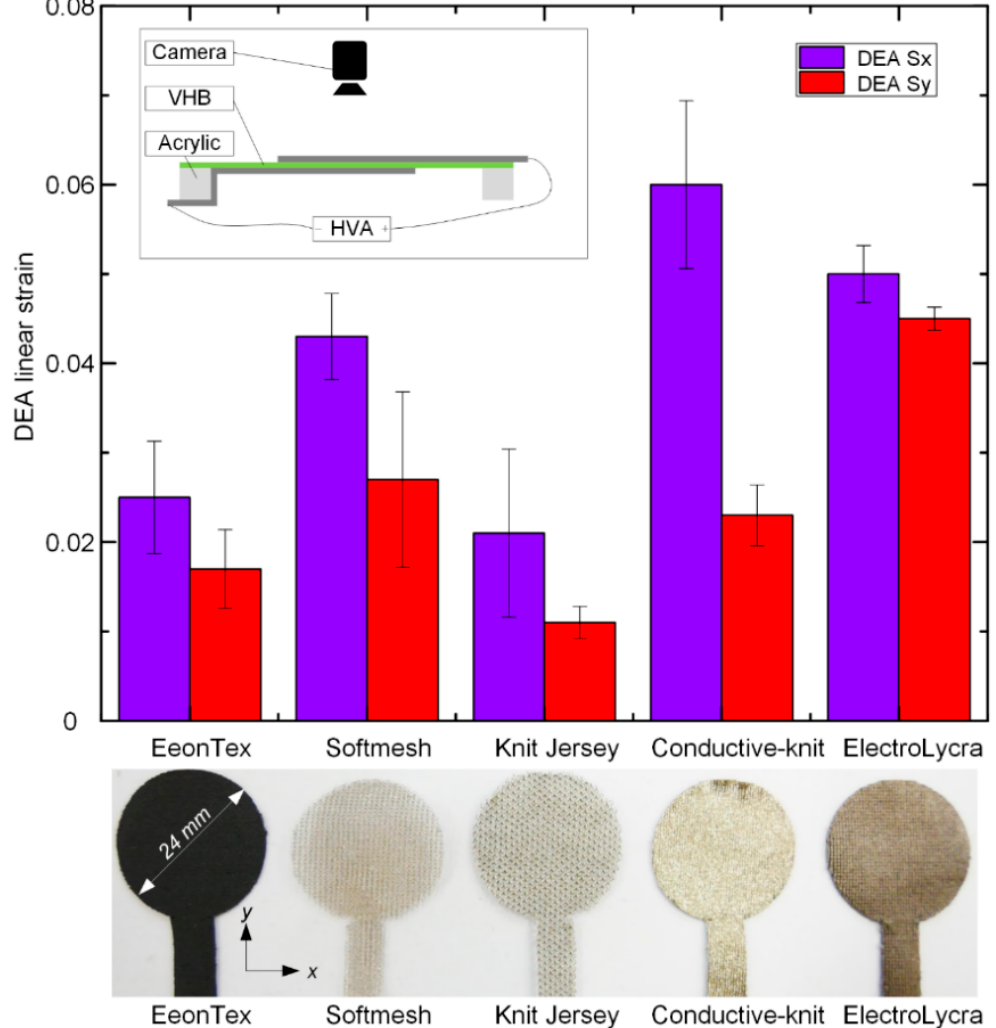
Figure 1. Comparison of dielectric elastomer actuator (DEA) strains in x and y axis for the five conductive textiles at 6 kV. Inset shows the schematic diagram of the test setup. VHB is a 3M adhesive tape brand and HVA is the abbreviation of high voltage amplifier.